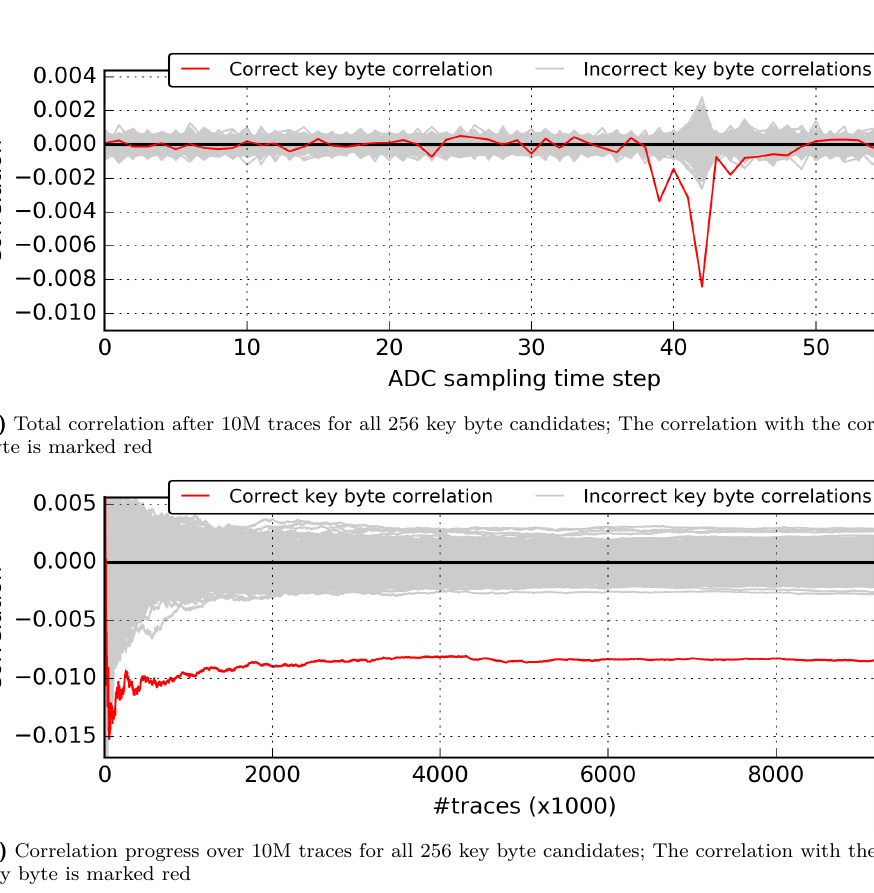
Figure 12: Results of a CPA attack on the 12th byte of the last secret round key of AES on the STM32F407VG Discovery #2 @56MHz with the ADC connected to Vdd and the program compiled with the -O0 optimization